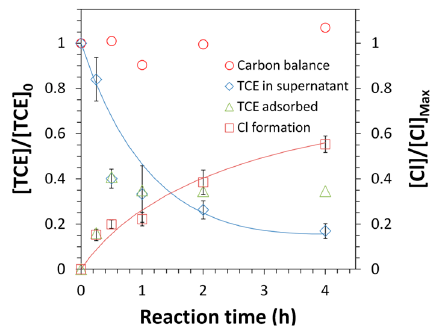
Figure 14. Trichloroethylene (TCE) dechlorination and chloride formation by Fe/Pd functionalized N- SPVDF membranes. TCE in supernatant analyzed by extraction of supernatant while TCE adsorbed analyzed by extraction of membrane after reaction with TCE. Cl − formation results from the analysis of supernatant for chloride ions using ion exchange chromatography. [Fe] 0 = 0.58 ± 0.02 g/L, [Pd] 0 = 1.25 ± 0.25 wt % of [Fe] 0 . [TCE] 0 = 0.28 mM, V = 20 mL. The maximum chloride concentration is 0.83 mM (complete dechlorination).